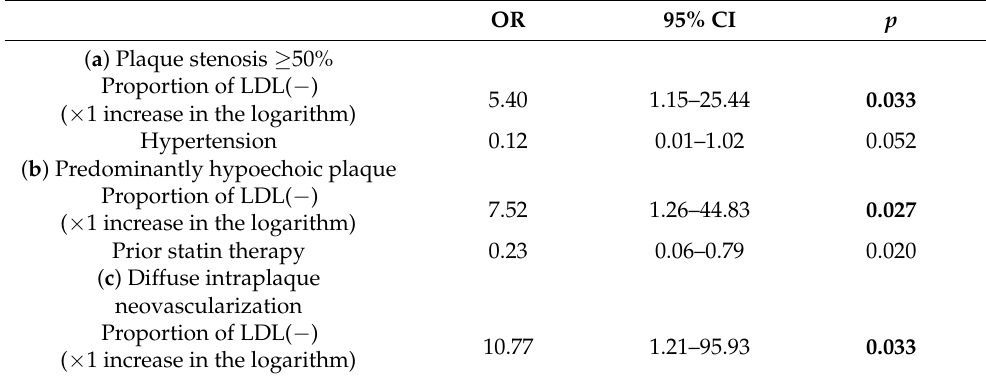
Table 3. Multivariable logistic regression analysis of predictors of carotid vulnerability.